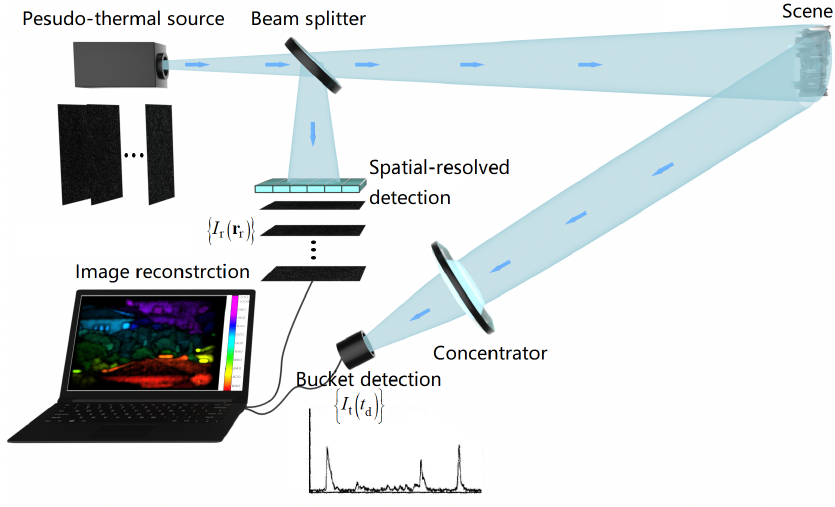
Figure 2. Schematic diagram of the GI LiDAR system. It uses light fields with designed spatiotempo- ral fluctuations, which are generated by modulating a pulse laser with a diffuser to illuminate the object, then acquires the return signal with a bucket detector, and retrieves the 3-D spatial-depth image information by the second-order correlation between illuminated light fields and the return